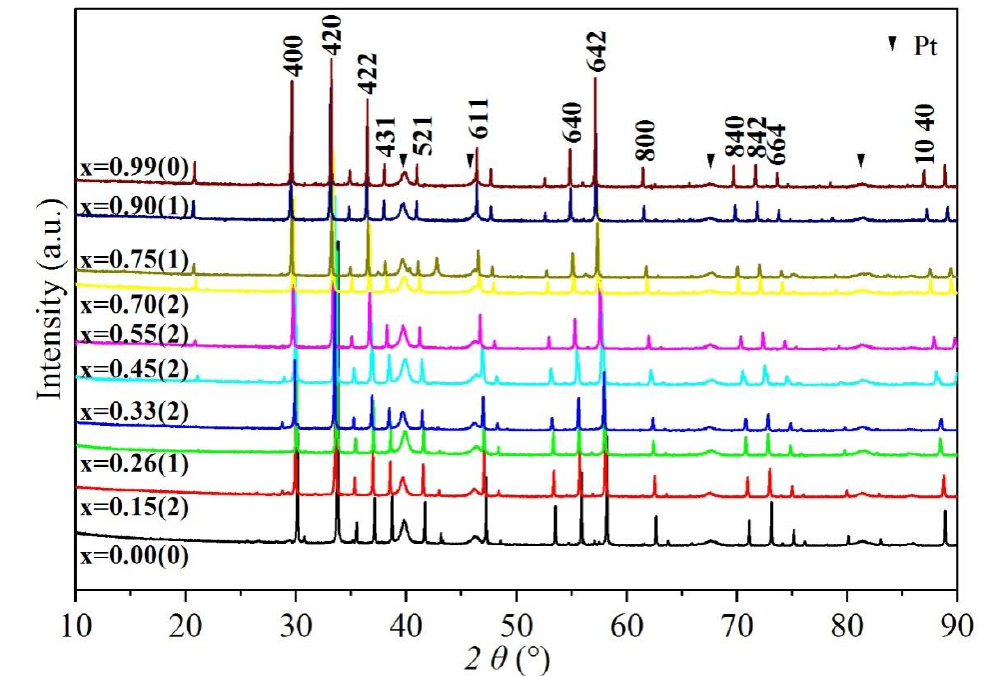
Figure 2. X-ray di ff raction patterns of grossular–andradite solid solutions at ambient P–T condition. All the major peaks attributed to garnets are marked with hkl symbol (Miller indices). The Bragg peaks of Pt powder are denoted by solid triangles (Pt standard was not used in this study, see text). The number represents the mole fraction of andradite component ( x = Fe 3 + / (Fe 3 + + Al 3 + )). The unit-cell parameters and volumes of various samples using both powder and single-crystal XRD showed little di ff erence (Table 5). The unit-cell parameters of grossular and andradite end-member garnets were 11.848(0) and 12.054(0) Å (PXRD) and 11.842(0) and 12.053(1) Å (single-crystal XRD), respectively, which are consistent with previous studies (Table 6). The least-squares method was used to fit both powder and single-crystal XRD data in this study: a = 11.836(2) + 0.220(4) × X Fe ( R 2 = 0.99). The fitting results of four sets of data were as follows: a =